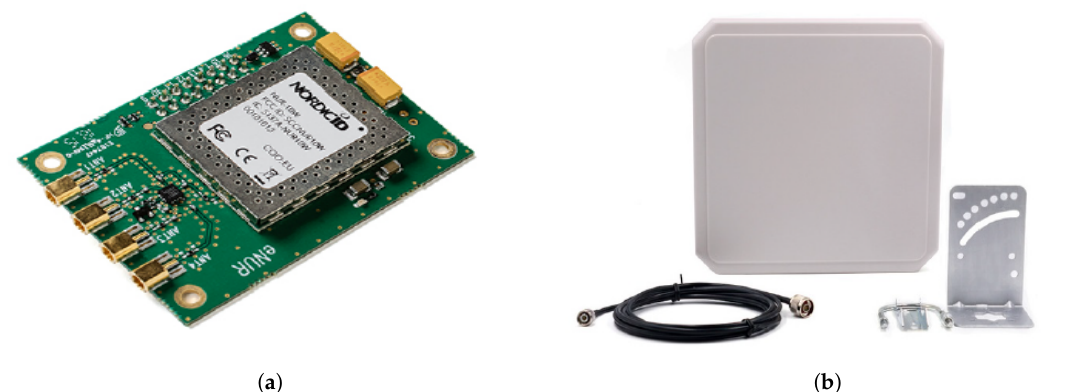
Figure 6. RFID Reader: ( a ) Nordic ID eNUR RFID reader and ( b ) antenna of the eNUR